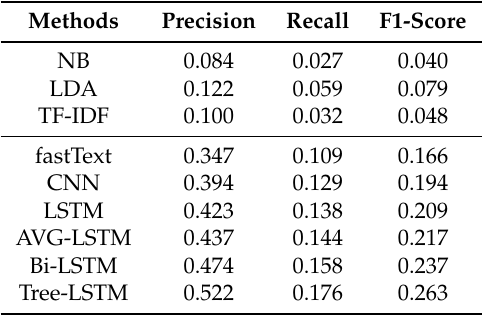
Table 4. Evaluation results of different methods for top-1 hashtag recommendation in Zhihu dataset.